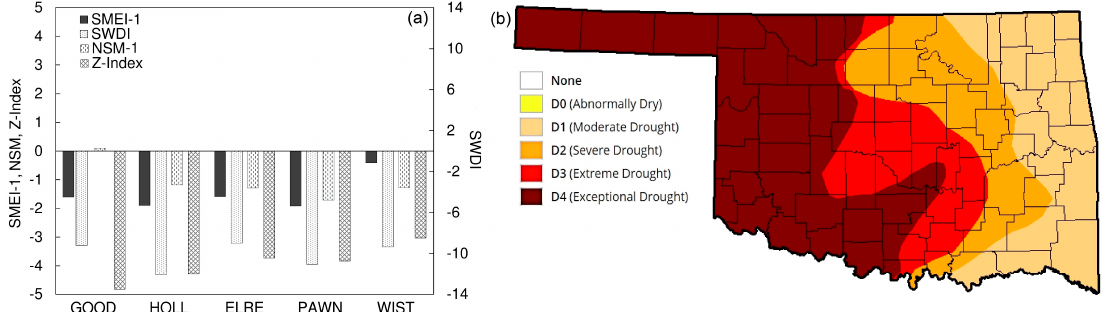
Figure 7. Magnitudes of selected drought indices for July 2011 at five individual study sites ( a ) and the corresponding USDM map ( b ).